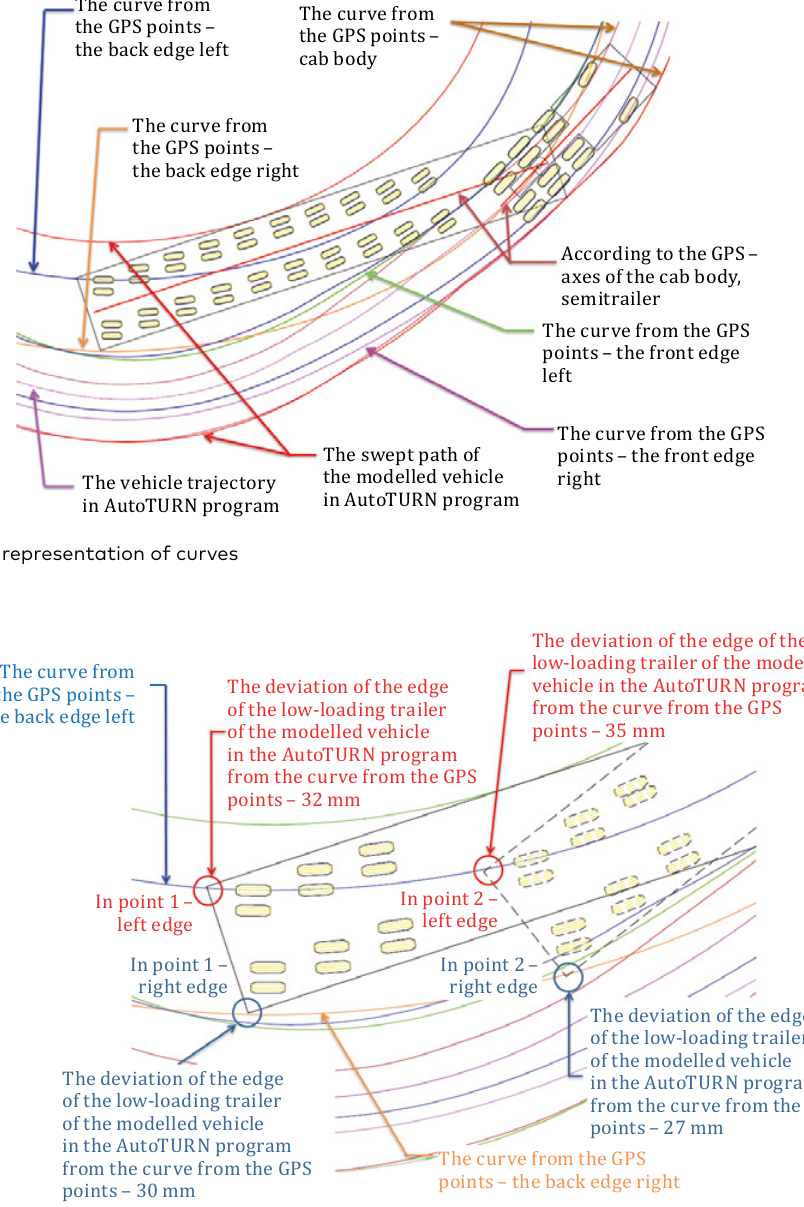
b) representation of deviations of individual edges of the low-loading